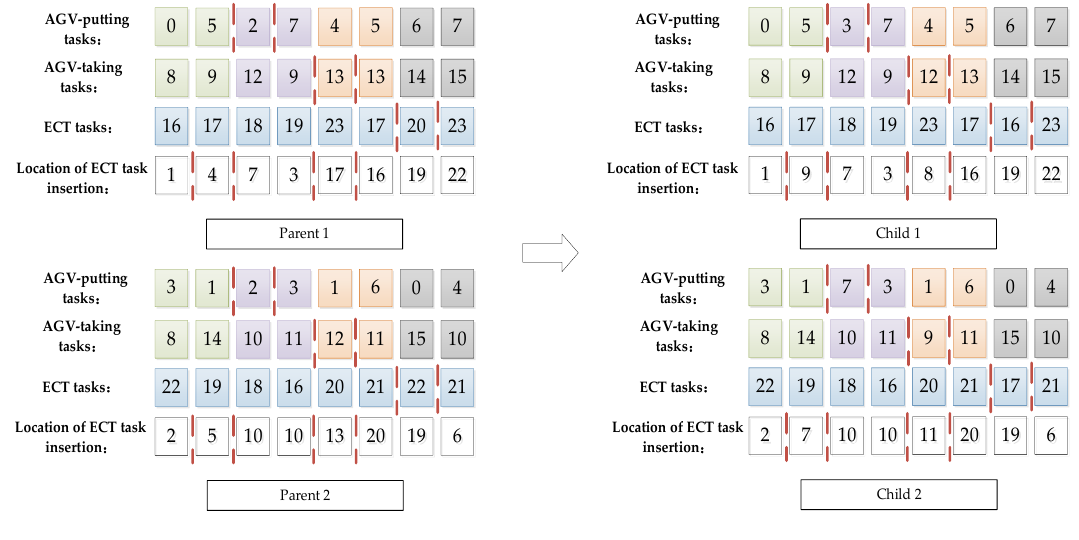
Figure 9. Mutate the task sequence.